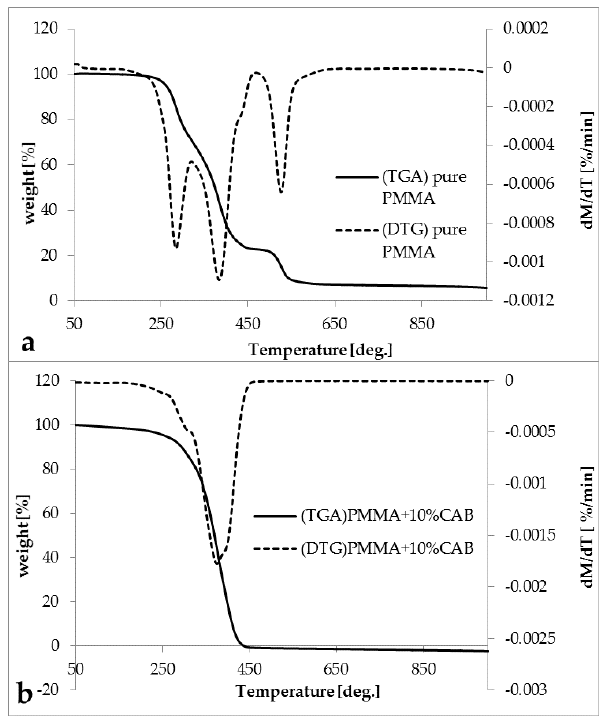
Figure 5. TGA- trace for ( a ) pure PMMA; and ( b ) PMMA/10%CAB.